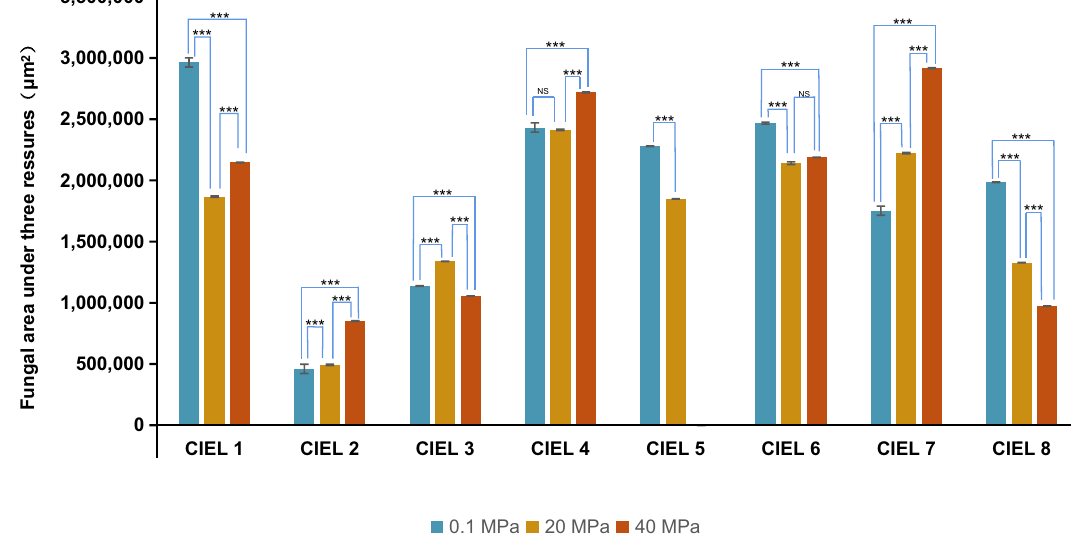
Figure 4. The growth rate of hadal-derived fungi isolated and cultured in this experiment under the different preset pressures. Under the same cultural conditions, the area of the strain changed regularly with the change of pressure. The unit of the area was μm 2 . T-test was used for pairwise comparisons. (NS p > 0.05, *** p <